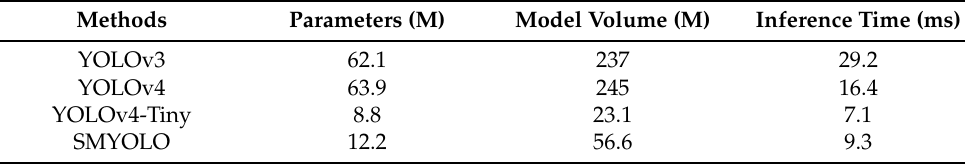
Table 1. Comparison of experimental results of different network architectures.